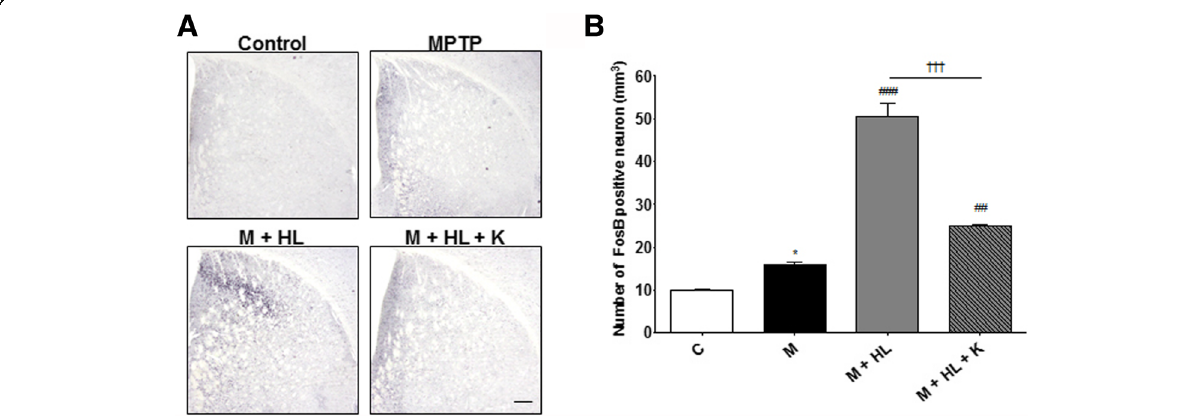
Fig. 9 Effects of combination treatment on abnormal FosB activation in the striatum. Coronal sections showing FosB staining in each group ( a ). Graph showing altered FosB levels in the HL group compared to the control group and combination treatment group ( b ). C: control, M: MPTP, K: KD5040, HL: high dose of each dose of -dopa. Scale bar: 200 μ L